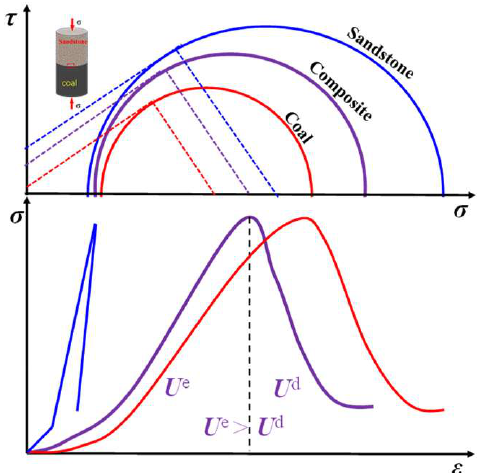
Figure 1. Failure and disaster discrimination model of composite coal–rock mass ( U e is the pre-peak stored elastic energy; U d is the post-peak dissipation elastic